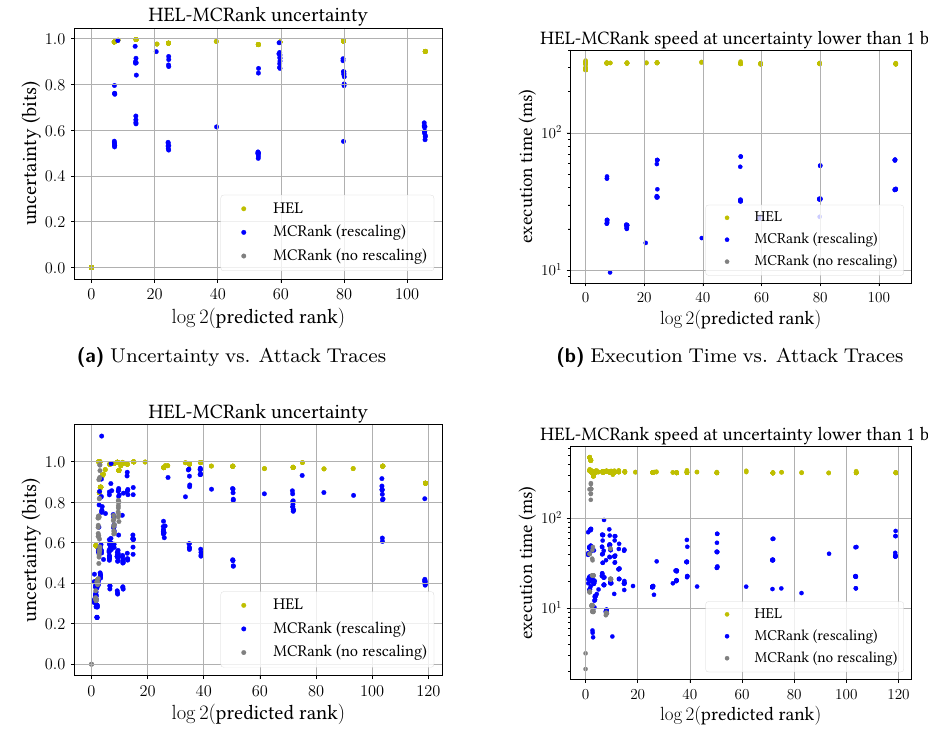
Figure 8: Deep-learning attacks on real traces of a protected implementation of AES-128 (ASCADv2) for increasing number of attack traces. MCRank is faster (b,d) for similar or lower (i.e., better) uncertainty (a,c) than Histogram Enumeration also in this case. (a,b) and (c,d) correspond to two different attacks presented in [MS21] (with and without knowledge of the permutation index). With rescaling (blue) MCRank achieves the desired accuracy below 1 bit, while without rescaling (gray) this is often not possible (missing gray points). √ size n (the SEM is O (1 / n )), whereas execution time is only linear with it ( O ( n )). As a result, MCRank is orders of magnitude faster than the state-of-the-art Histogram